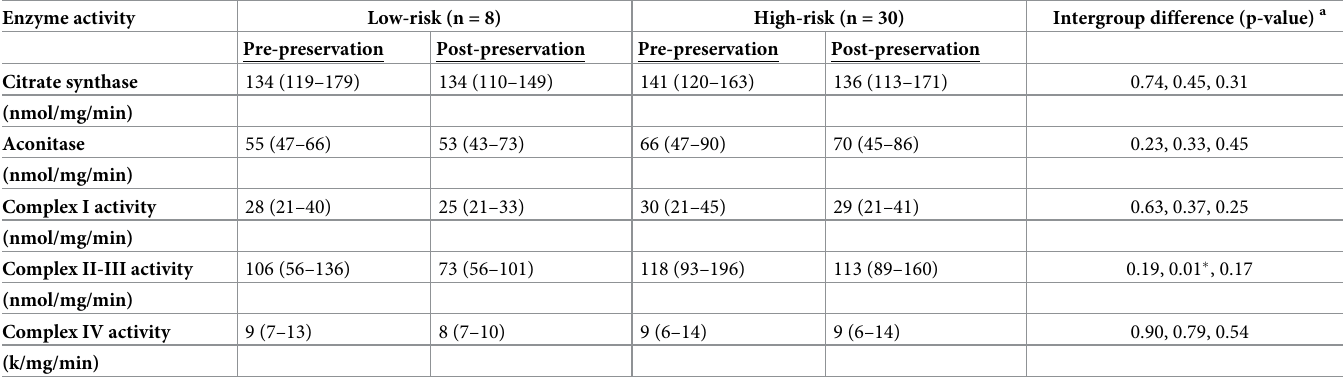
Table 4. Mitochondrial enzyme activity in low- and high-risk livers.